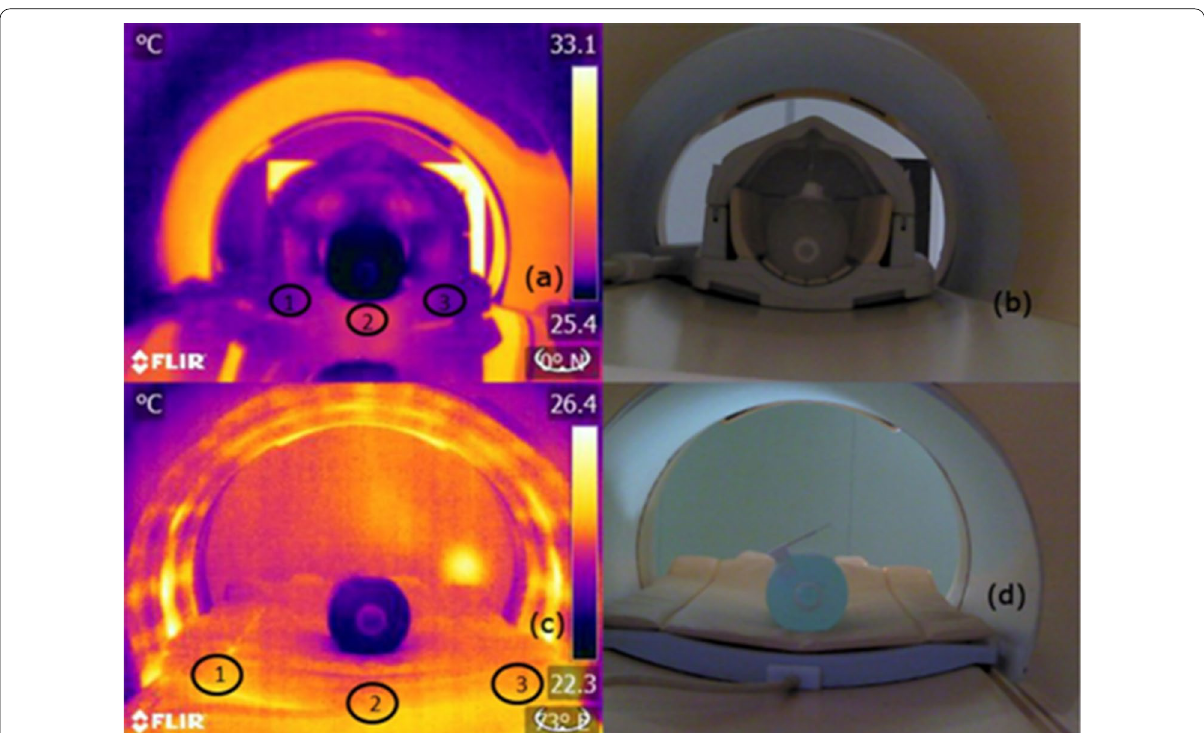
Fig. 2 Visible and IR images of MRI coils: a IR image of 3.0 T MRI head coil, in which are highlighted the three ROIs used in temperature trend evaluation. b Visible image of 3.0 T MRI head coil. c IR image of 3.0 T MRI body coil and the three ROIs for temperature assessment. d Visible image